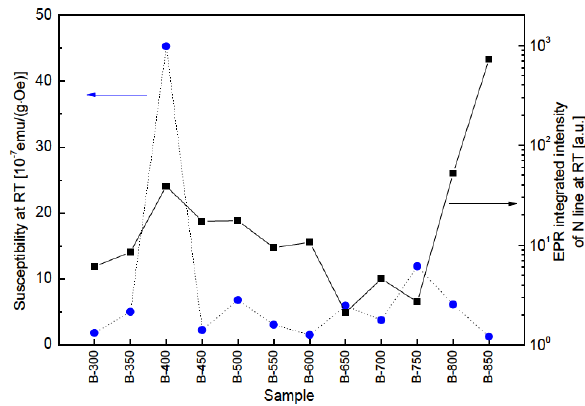
Figure 11: Dc susceptibility (left axis) and EPR integrated intensity of the N component (right axis) at RT for all studied samples.